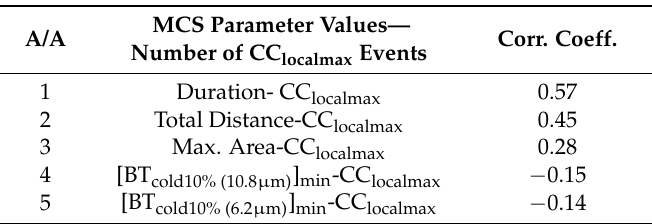
Table 3. Spearman Correlation coefficients among the number of CC localmax events and MCS parameters. All the correlation coefficients are statistically significant at the 0.05